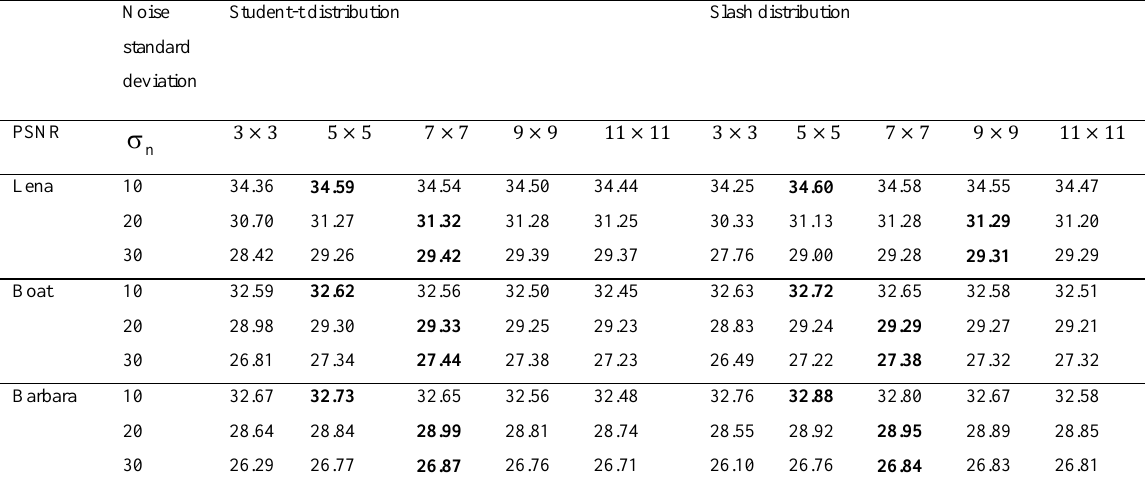
Table 1. Impact of window size on the denoising performance.